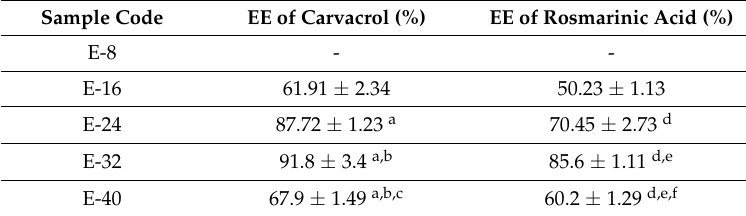
Table 2. Encapsulation efficiency (EE) of prepared nano-microfibers with oregano ethanolic extract. Sample Code